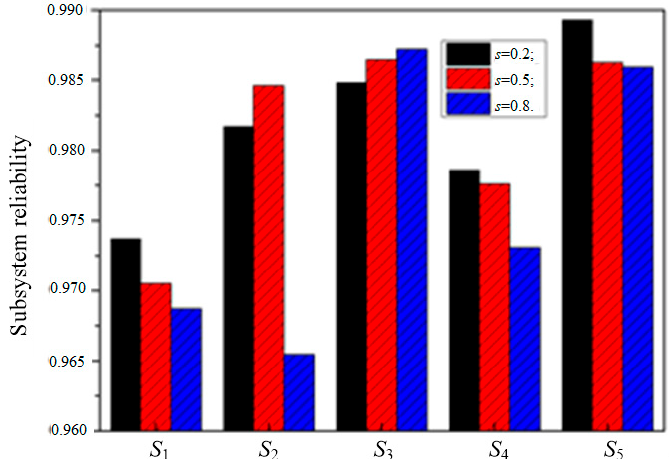
Figure 11. Best compromise reliability optimization design schemes with s .